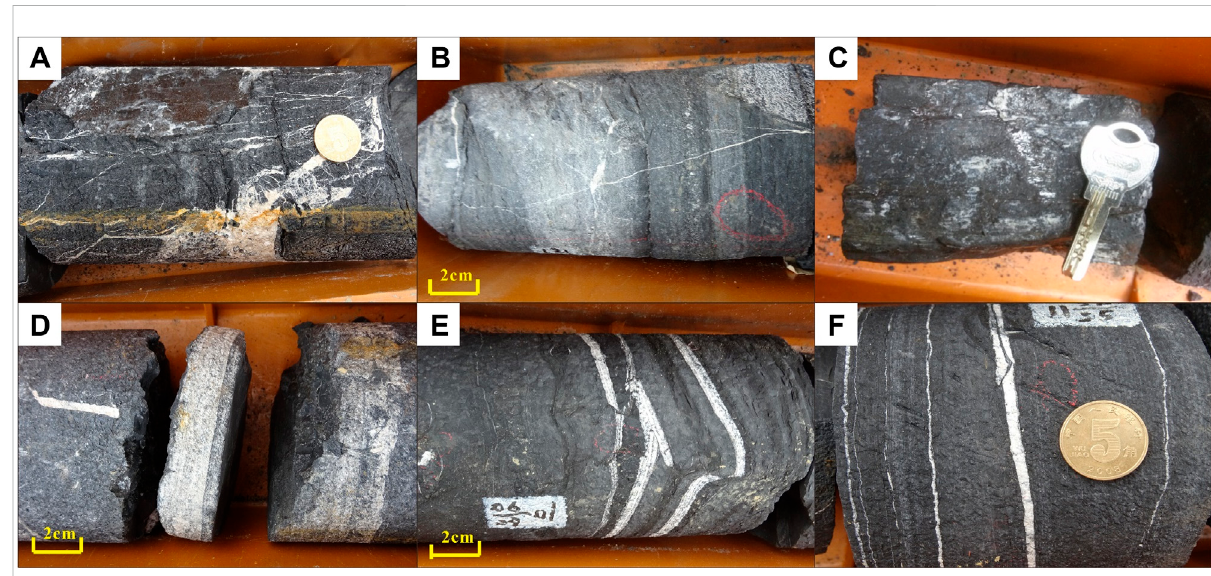
FIGURE 2 Niutitang Formation shale fracture photos in Fenggang No.3 block. (A) Tectonic fractures. (B) High-angle shear fractures. (C) Low-angle slip fractures. (D) Construct pressure solution suture. (E) Tensile fracture formed by crumping. (F) Horizontal interlayer